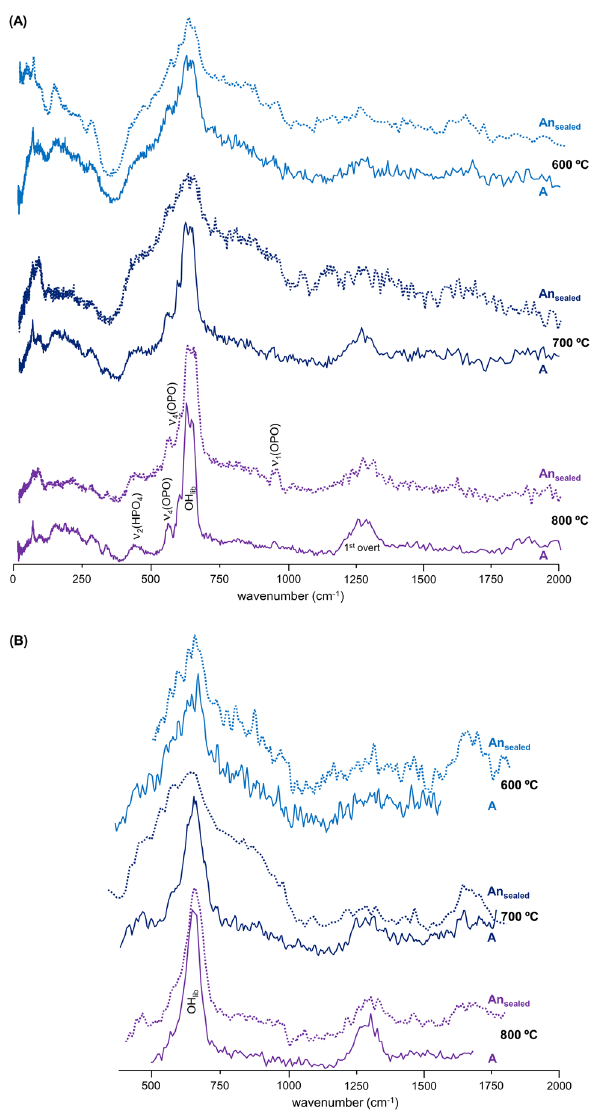
Figure 6. INS spectra of human femur burned at different temperatures (600 to 800 °C) either under aerobic ( A ) or anaerobic/sealed (An sealed ) conditions. ( A ) Data measured in TOSCA; ( B ) Data measured in MAPS (with 2024 cm −1 incident